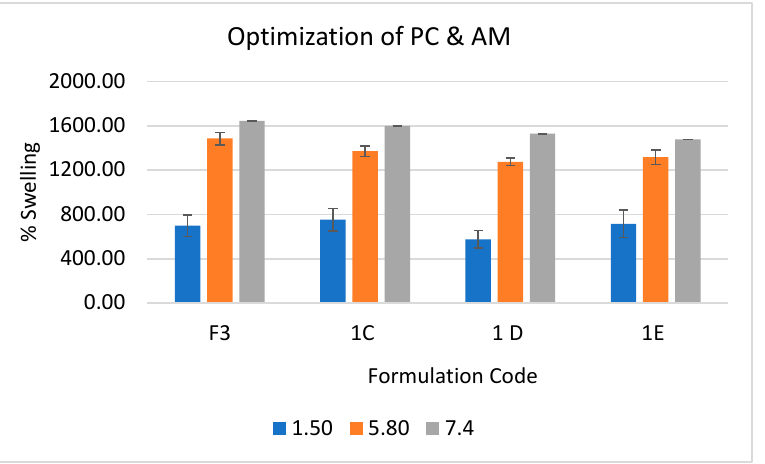
Figure 2. Swelling behaviour of hydrogels containing different PC/AM ratio at various phosphate buffer pH (1.5, 5.8, 7.4).